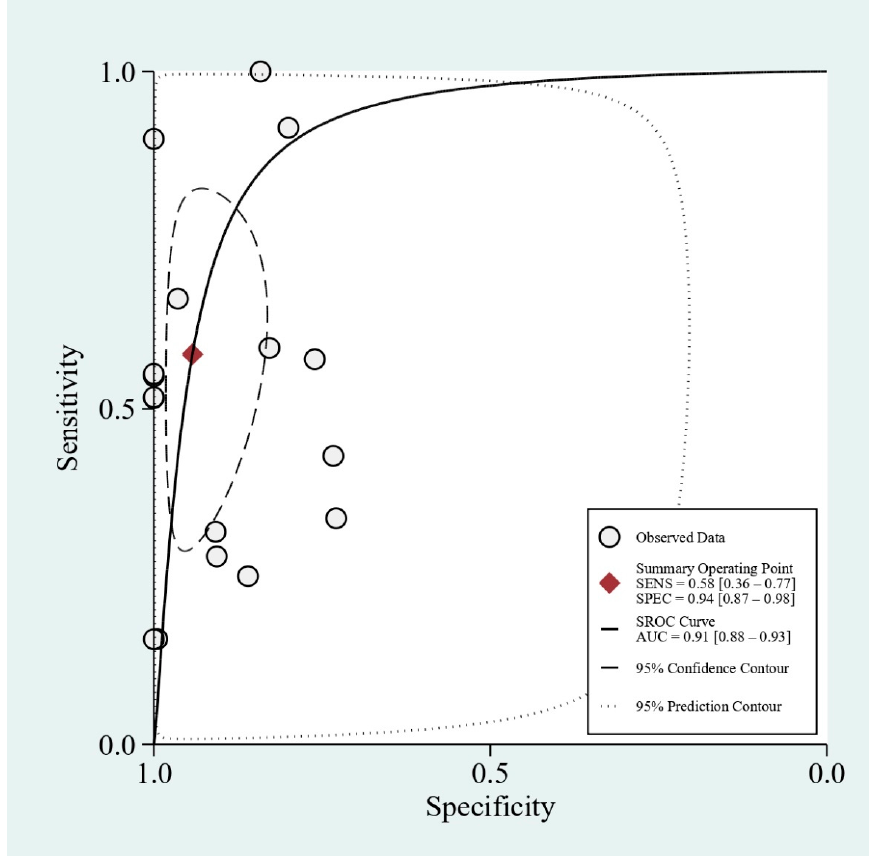
Figure 3. Area under the summary receiver operating characteristic curve of conventional X-rays for detecting FBs in the upper digestive tract.